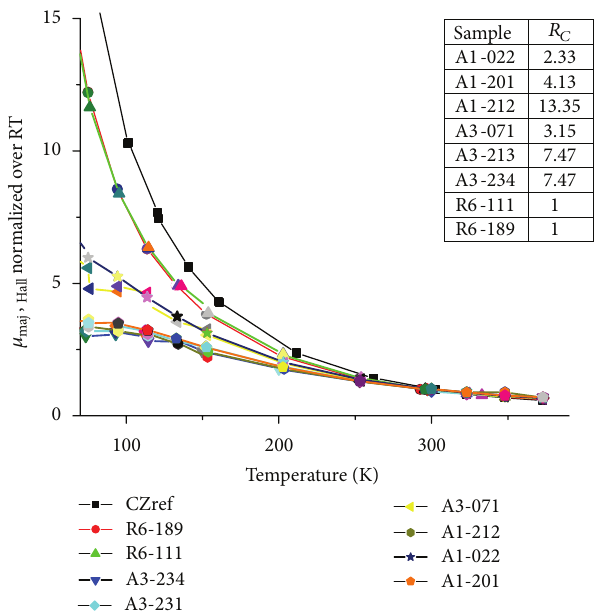
Figure 1: Temperature-dependent majority carrier mobility, 𝜇 , as measured by the Hall-effect setup, normalized values maj , Hall (ratio of the measured value at the given temperature over the measured value at room temperature). The compensation ratios ( 𝑅 𝐶 ) of the different samples are reported in the table on the right. Adapted from [14].